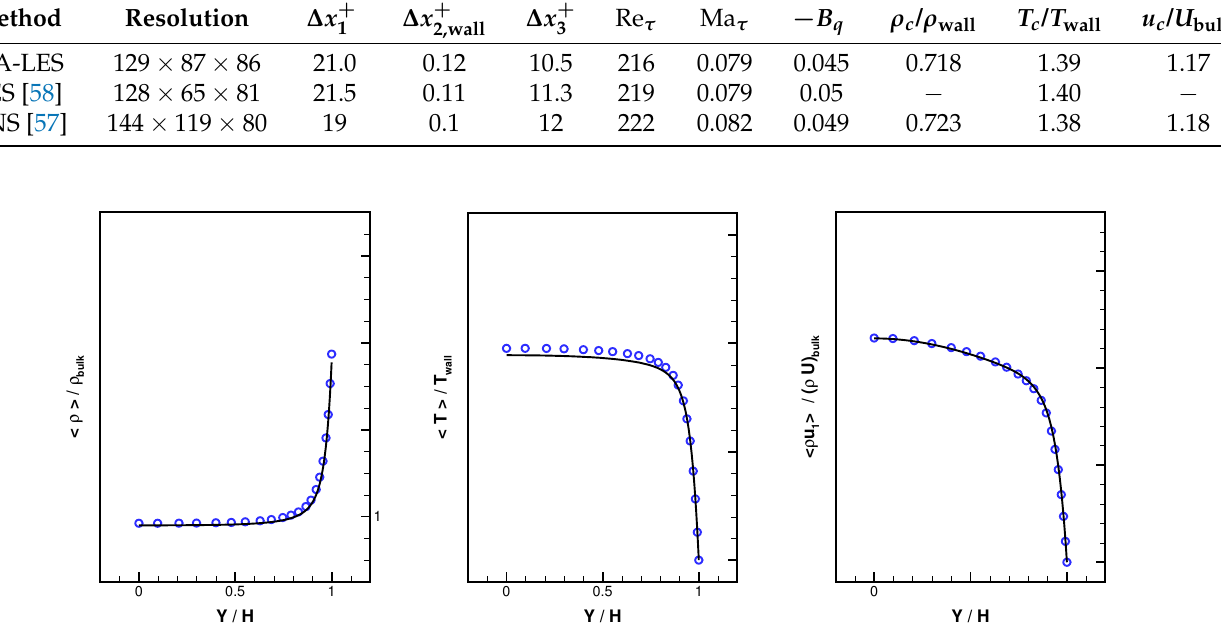
Figure 2. WA-LES of supersonic channel flow: profiles of normalized mean density, temperature, and streamwise momen- tum, compared to reference DNS